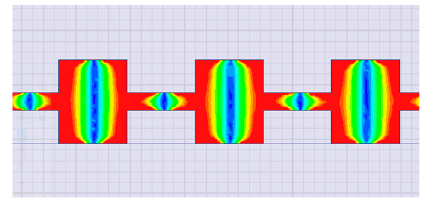
Figure 3. Schematic diagram of electric field distribution of a microstrip patch antenna array.